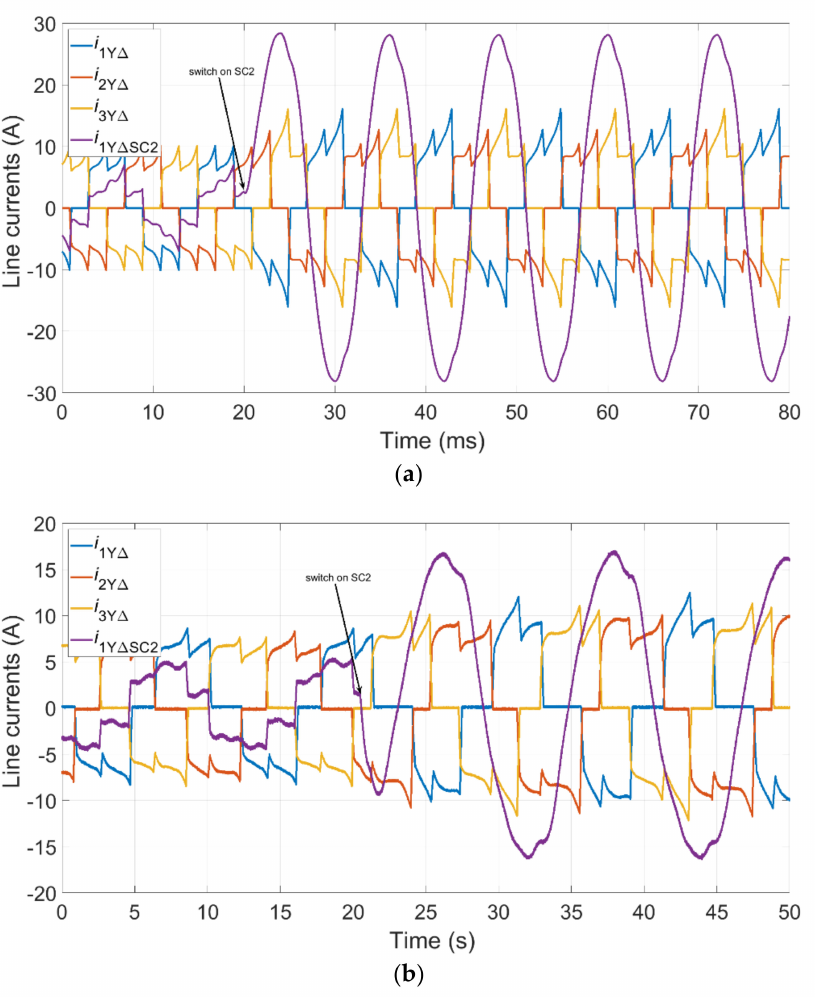
Figure 14. Y (cid:52) configuration—waveforms of currents—healthy to SC2: ( a ) numerical calculations, ( b ) laboratory tests.